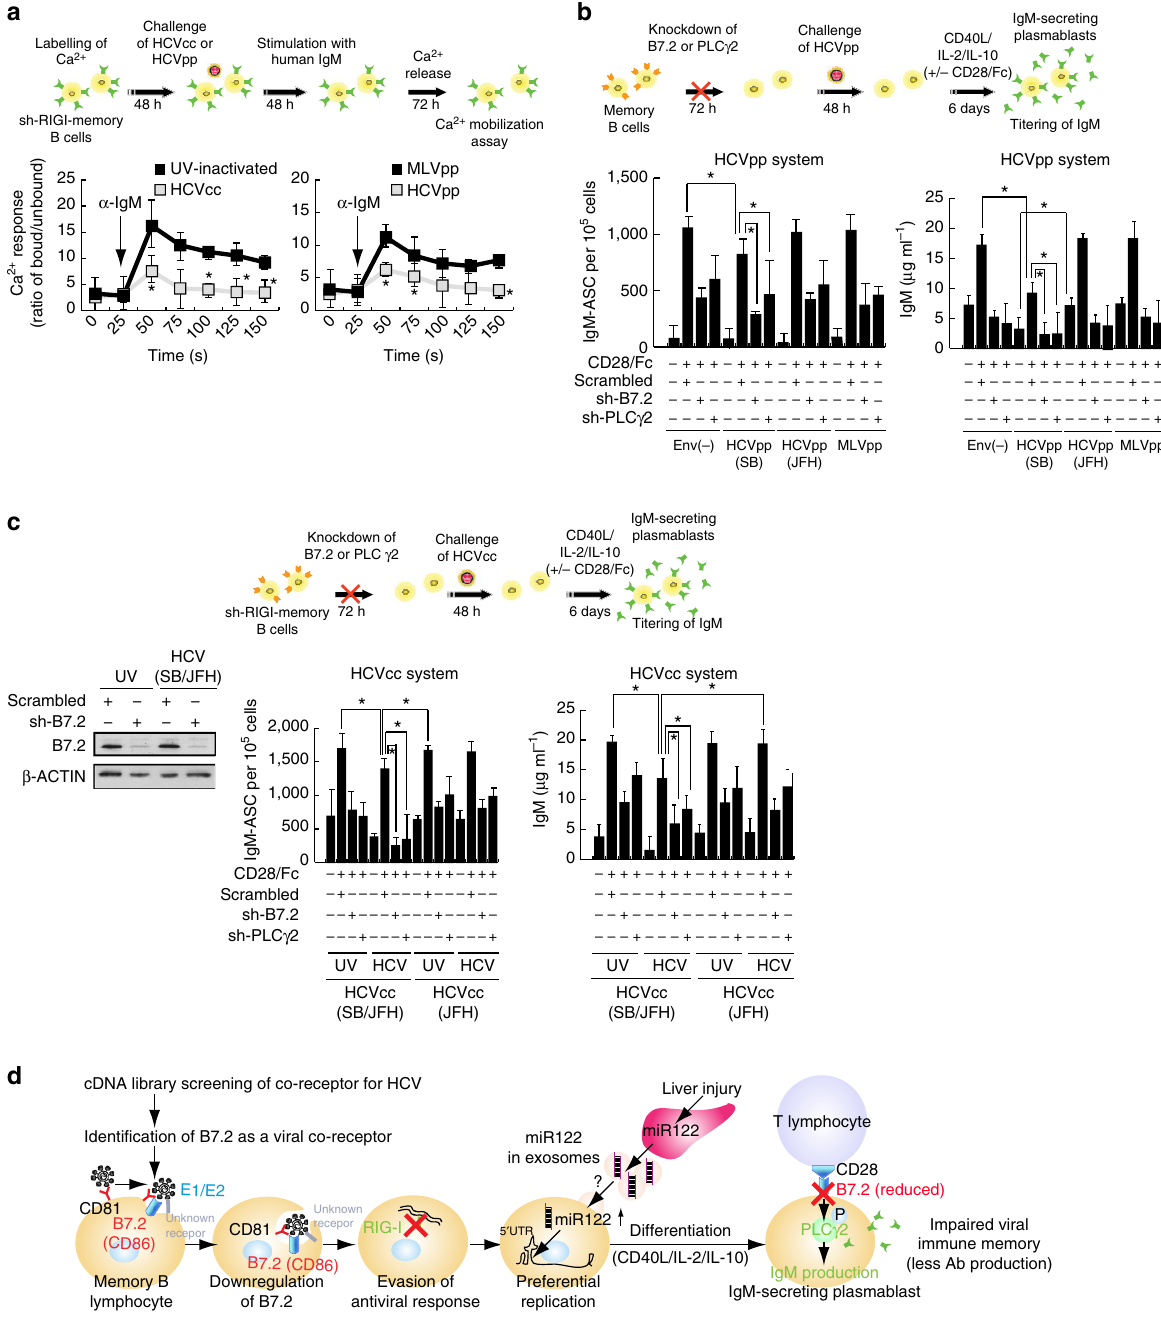
Figure 9 | HCV infection impairs antigen recall responses in memory B cell. ( a ) HCV-infected CD27 þ B cells, compared to uninfected CD27 þ B cells, have attenuated Ca 2 þ responses after BCR cross-linking. B cells from healthy donor were loaded with Indo-1-AM, stained with anti-CD27 and warmed to 37 (cid:2) C. After establishing a baseline for 30s, cells were stimulated with 10 m gml (cid:2) 1 goat F(ab 0 )2 anti-human IgM. Kinetic graphs represent ratios of bound/ unbound Indo-1 AM over time for CD27 þ B-cell populations. Arrows indicate addition time of F(ab 0 )2 a –human IgM (* P o 0.05, t -test, n ¼ 3). Error bars represent s.d. ( b ) Signals by anti-B7.2 Ab induce the production of IgM by memory B cells. Memory B cells (5 (cid:3) 10 3 cells per well) were cultured with different concentrations of anti-B7.2 (0.5 m gml (cid:2) 1 ); after 5 days, supernatants from control and experimental wells were collected and IgM levels were measured. Data are presented as the fold-increase above memory B cells activated with a CD40L þ IL-2 þ IL-10, and a species- and isotype-matched control Ab (* P o 0.05, t -test, n ¼ 3). Error bars represent s.d. ( c ) Similar assays were performed using HCVcc as described with HCVpp above (* P o 0.05, t -test, n ¼ 3). Error bars represent s.d. ( c , inset ) Silencing effect of shRNA targeting B7.2 was confirmed by immunoblot. ( d ) A model of lymphotropic HCV infection in memory B cells. B7.2 serves as one of the co-receptors for HCV-SB infection of B cells. B7.2 (CD86) mediates lymphotropism of HCV infectious clone derived from HCV SB strain towards human memory B cells and its binding suppresses the cells’ function by downregulating surface expression of B7.2. Evasion of antiviral responses (that is, RIGI), induction of miR-122 , and another host factor targeting HCV 5 0 -UTR are involved in stimulating HCV replication in B cells. HCV-mediated downregulation of B7.2 impairs anti-viral immune memory, including reduction of antibody production and antigen recall